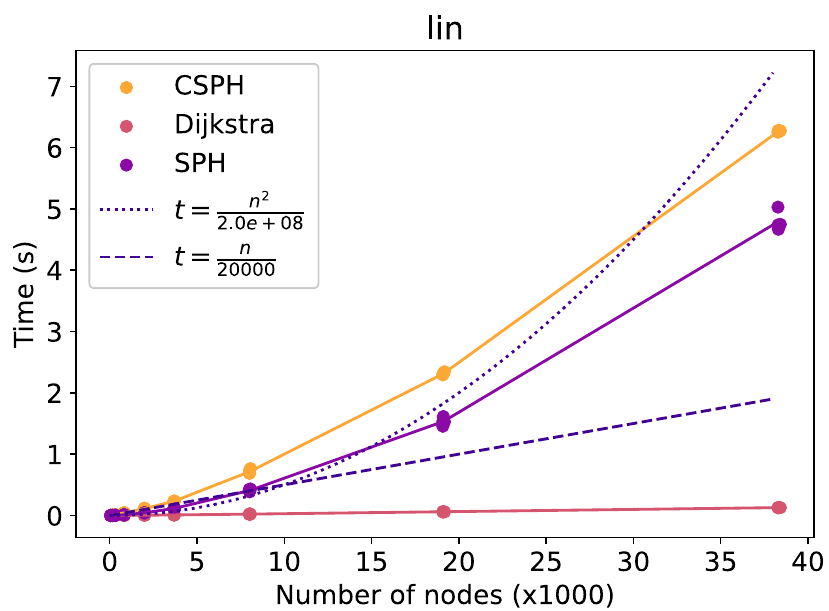
PLOS ONE | https://doi.org/10.1371/journal.pone.0270147 June 16,